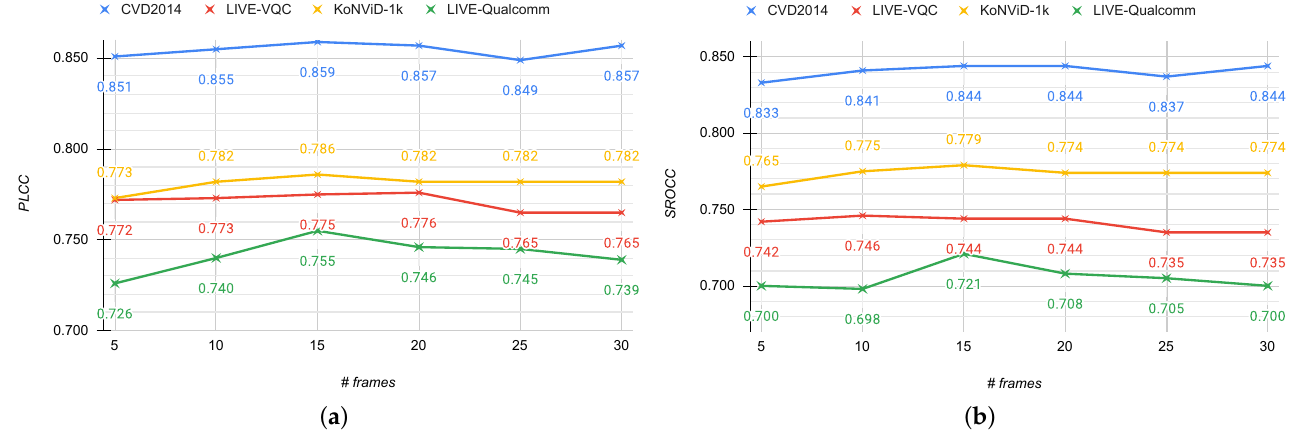
Figure 8. Mean PLCC ( a ) and SROCC ( b ) across 100 train–test random splits of the four considered datasets with respect to the number of sampled